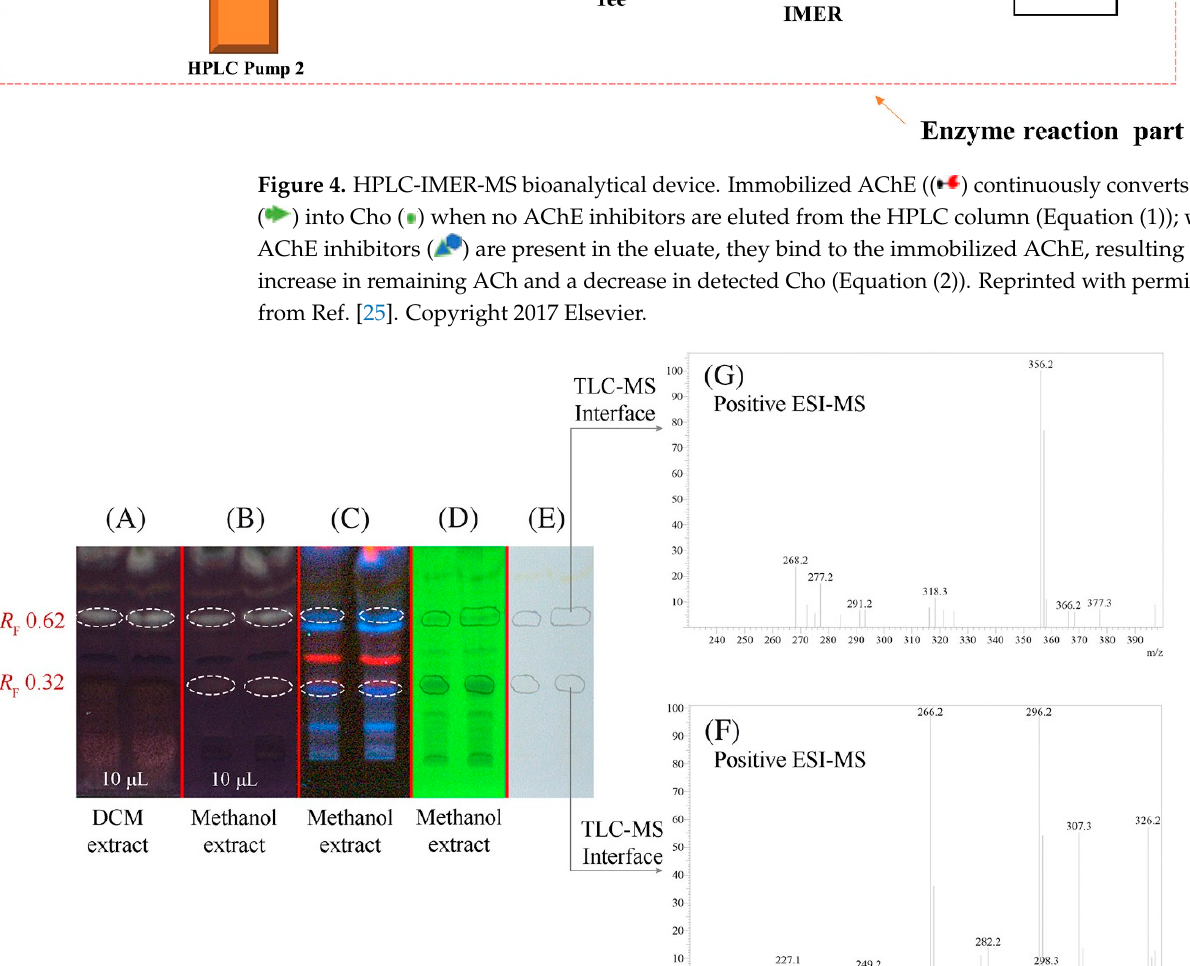
Figure 5. In the experiments, donepezil was used as a positive control. Anonaine, glaucine and less xylopine showed anti-acetylcholinesterase activity. and less xylopine showed anti-acetylcholinesterase activity.